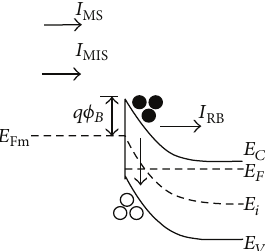
and (b) 𝑉 0.5 with 𝐼 for comparison. MS MIS